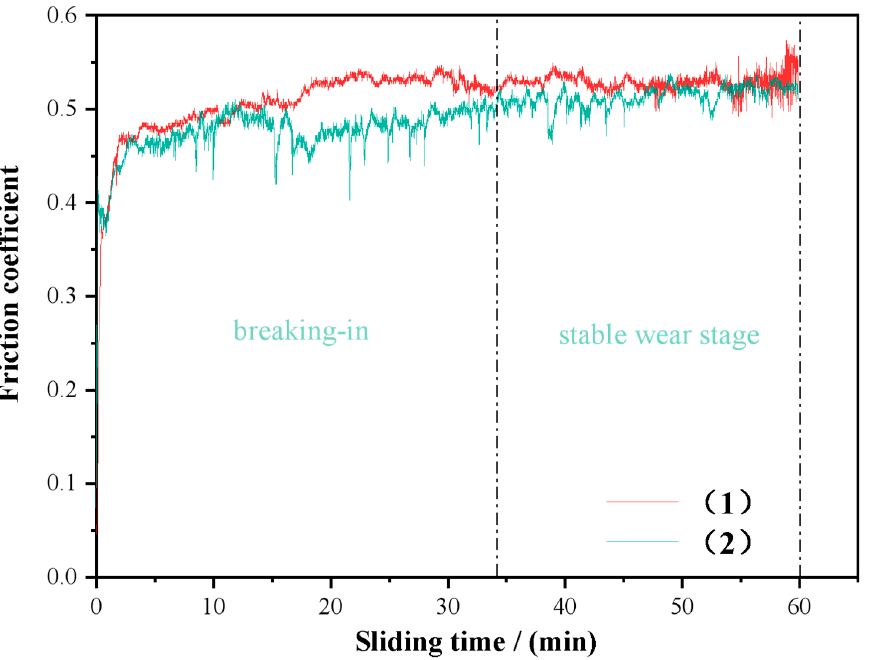
Figure 17. The friction coefficient of two samples. ( 1 ) is the friction coefficient of Fe-based; ( 2 ) is the friction coefficient of Ni-based.